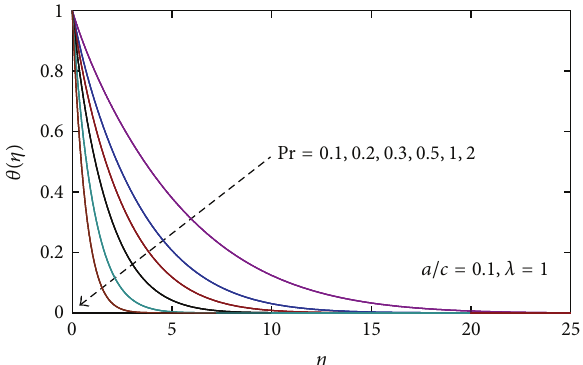
= 0.1, 0.2, 0.3,0.5,1,2